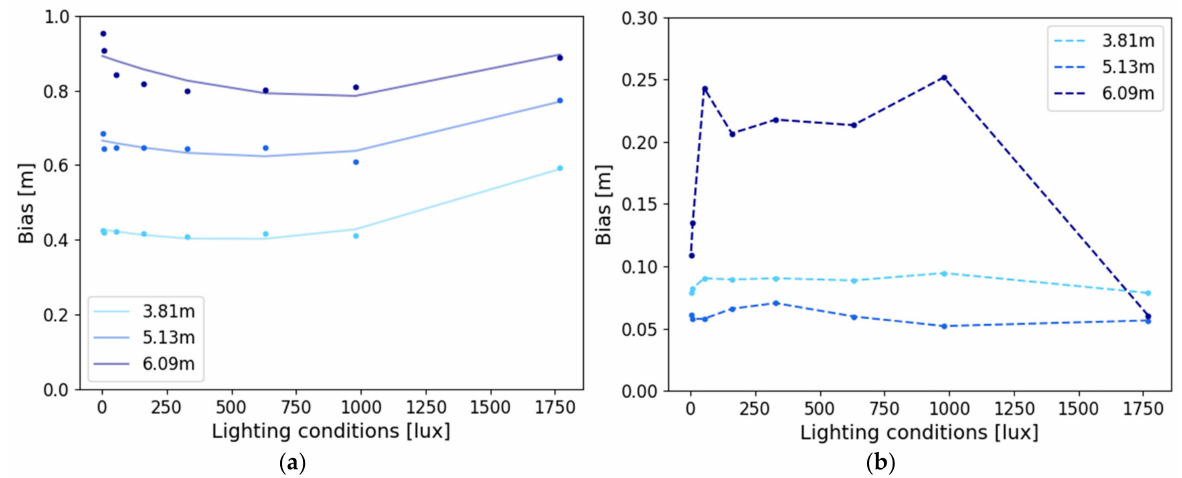
Figure 14. Performance evaluation of depth measurements by D455 (Cam 3): ( a ) bias and ( b ) precision in relation to the three measuring distances (light, middle, and dark blue values) and lighting intensity.